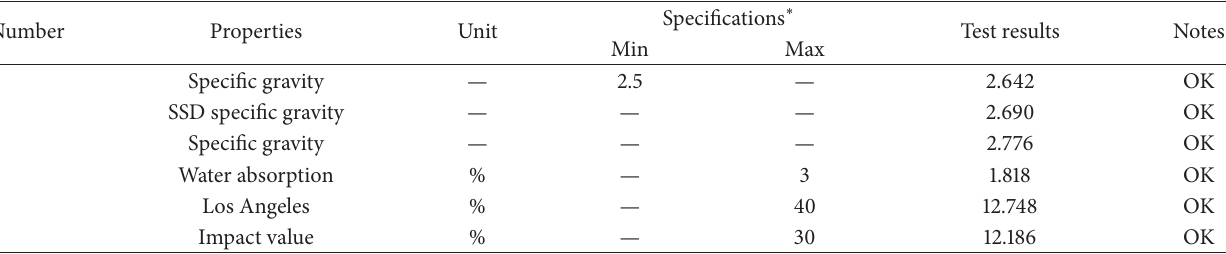
Table 4: Properties of regular coarse aggregate.